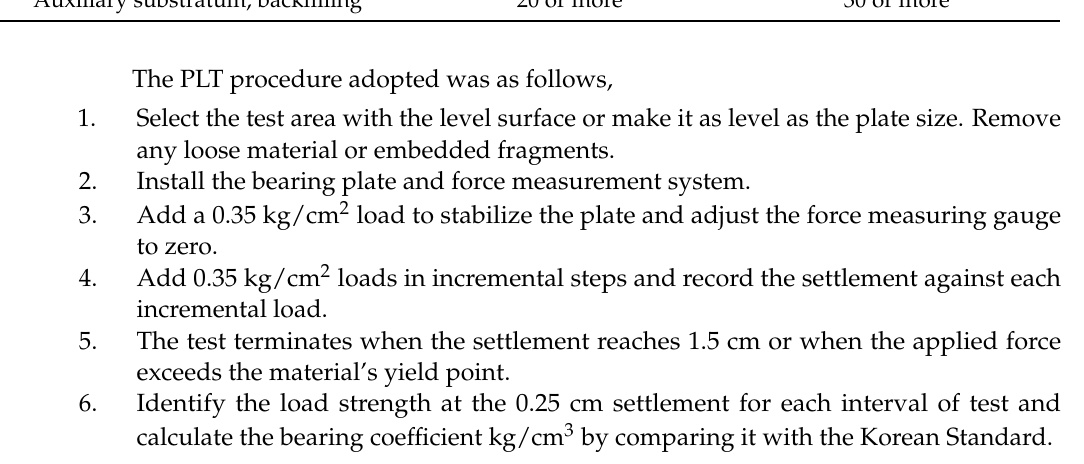
Table 5. Criteria for the bearing coefficient of the PLT according to Korean standards [35]. Type Settlement (cm) 0.125